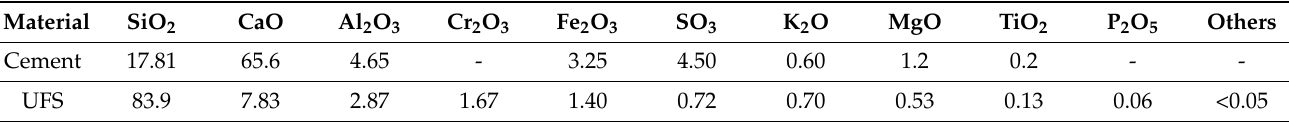
Table 2. XRF chemical composition of cement and UFS.